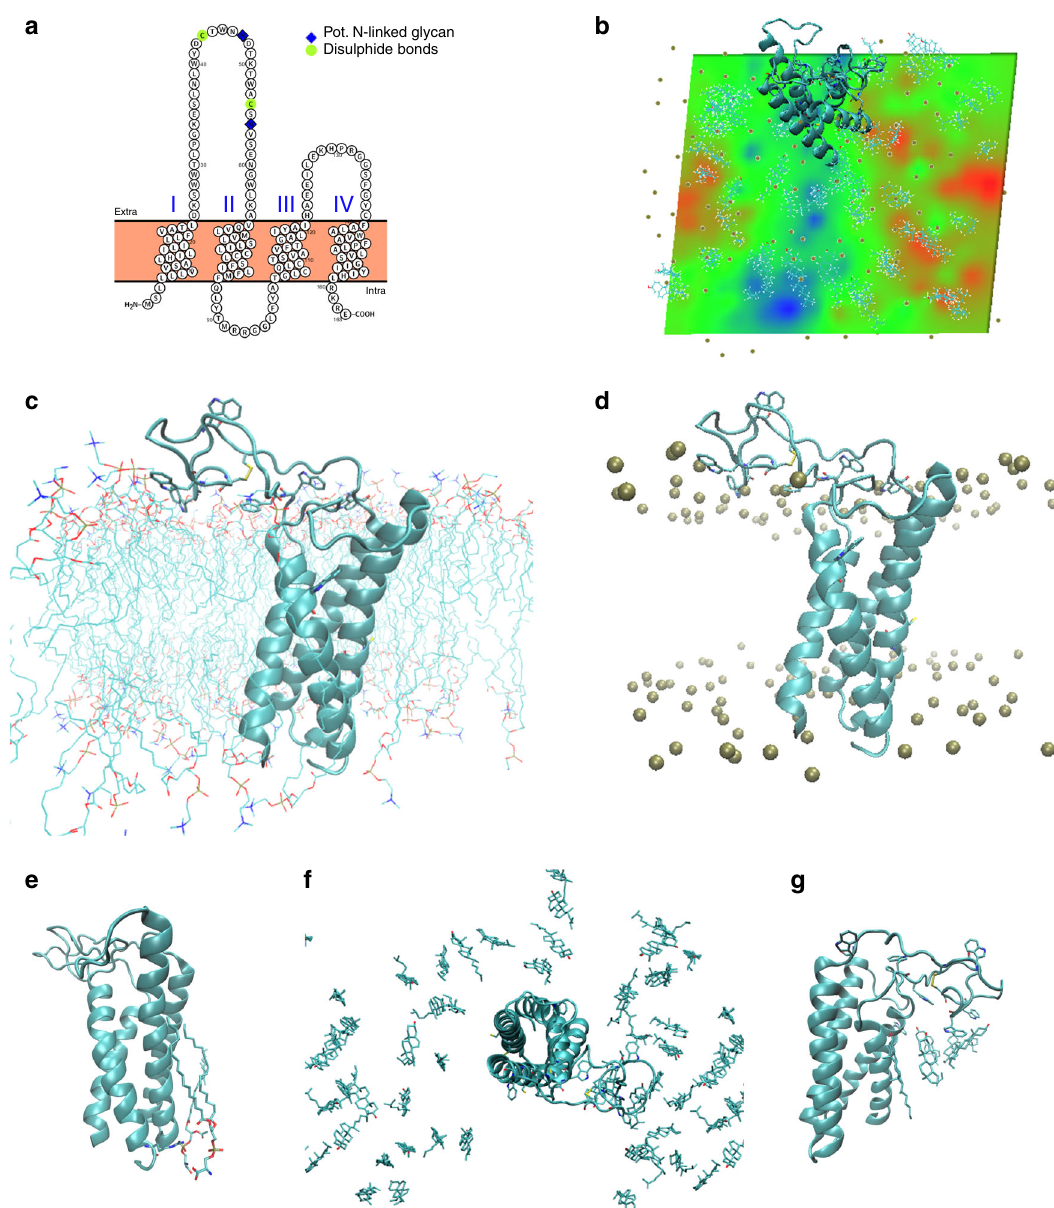
Fig. 4 Structural calculations and predications on membrane embedded EMP3. a Homology modelling using PROTTER software. Proposed topology of EMP3 based on homology with claudin-19. I – IV represent transmembrane segments with both termini placed in the cytoplasm. Proposed posttranslational modi fi cation sites are indicated. Model similar to previously published EMP family model 35 . b Predicted effects of fi rst extracellular loop interactions with the membrane interface and consequence for apparent membrane thickness. The fi rst extracellular loop was remodelled from initial homology model (based on claudin-19, PDB ID 3 × 29) 34 and embedded in a representative cytoplasmic membrane composed of (mole percentages) 50% phosphatidylcholine/25% cholesterol/15% phosphatidylethanolamine/10% phosphatidylserine (inner lea fl et only). All-atom explicit solvent molecular dynamics (MD) calculations (150 ns calculation time) were performed to re fi ne initial homology model. Membrane thickness (phosphate-to-phosphate) is represented as a heat map with relative changes in bilayer dimensions colour-coded (green: average; red: increased; blue: reduced). The polypeptide is represented as a cyan ribbon; gold spheres indicate phosphate atoms of phospholipids. N.B. due to periodicity of the calculation space, the larger blue region at bottom of map lies beneath the large extracellular loop of EMP3 (at top of map extending over the edge). c Tentative model after MD calculations. EMP3 is represented as cyan ribbon cartoon and phospholipids as stick representations. Tryptophan residues in the fi rst extracellular loop are shown (stick representation) to illustrate the high density of tryptophan residues within this loop (frequency of 0.15) as well as assumed intra-molecular disulphide bond (yellow). d as c but with phosphate atoms represented by gold spheres. e Phosphatidylserine molecules stably associated with the transmembrane segment are indicated by stick representation. These were observed to be coordinated by Arg160 (indicated by stick representation) located at the membrane interface near the C-terminus of the protein and remained associated with Arg160 for the majority of the trajectory. f Distribution of cholesterol molecules after MD calculations (stick representation), illustrating the relative accumulation of cholesterol beneath fi rst extracellular loop (blue region in panel B/reduced membrane thickness). View from top of the membrane block. g Close-up of cholesterol accumulation beneath fi rst extracellular loop as shown in ( f ), viewed from